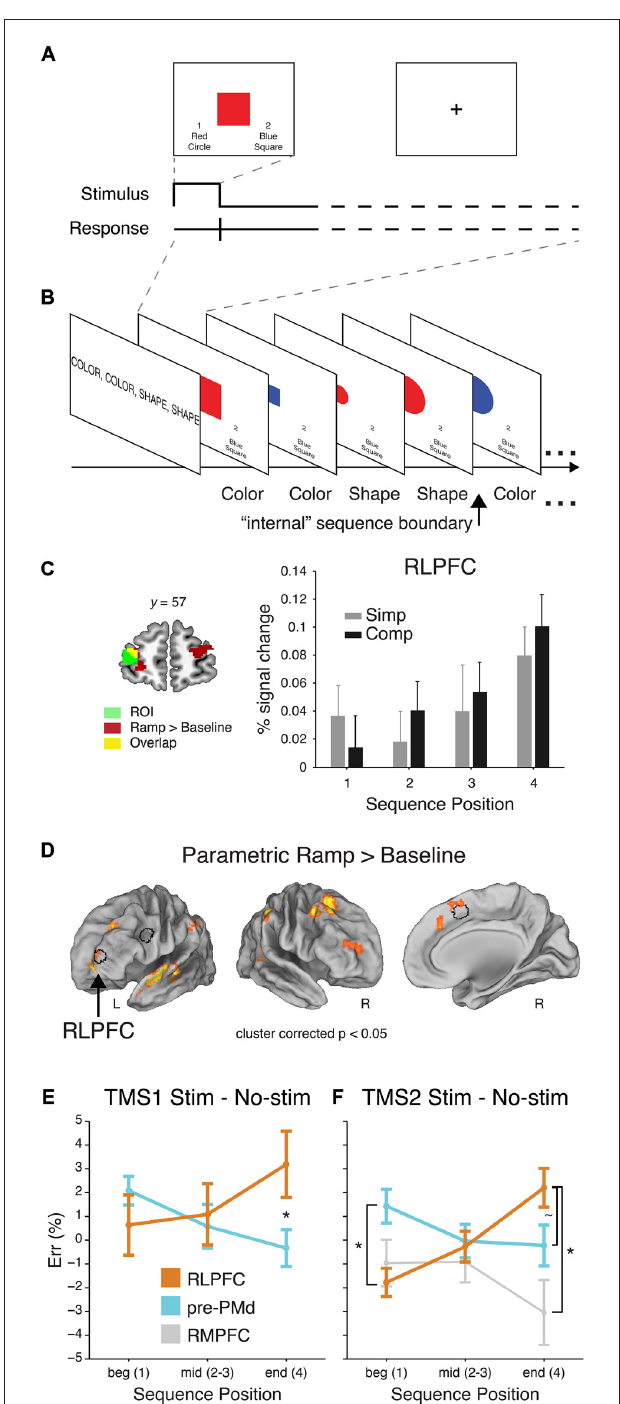
FIGURE 3 | Sequential control task, adapted from Desrochers et al. (2015b). (A) Example trial. (B) Partial example block with the task that should be executed on each trial (as remembered from the instruction screen). (C) Left: RLPFC ROI. Right: Mean percent signal change (+SEM) from the peak event-related response (at 6 s) of the voxels included the RLPFC ROI. (D) Voxelwise contrast of the Parametric Ramp regressors over baseline (extent threshold 172 voxels, note lateral views rotated ∼ 50 ◦ ). Outline of the RLPFC, pre-PMd, and SMA/pre-SMA ROIs used in the study in